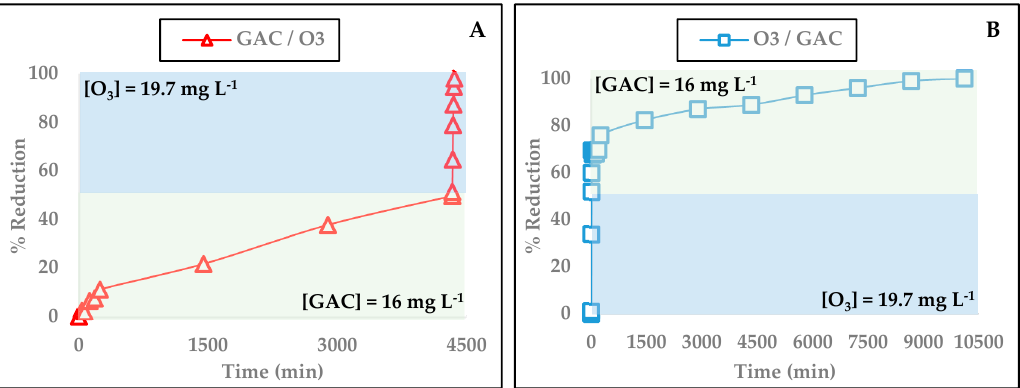
Figure 9. Reduction of simazine during the course of the combined experiment: ( A ) Experimental conditions GAC/O 3 : [Simazine 0 ] = 0.7 mg L − 1 ; [GAC] = 16 mg L − 1 ; [O 3 ] = 19.7 mg L − 1 ; pH 0 6.7; pH (20 min) 4.2–4.5; T = 25 °C. ( B ) Experimental conditions O 3 /GAC: [Simazine 0 ] = 0.7 mg L − 1 ; [O 3 ] = 19.7 mg L − 1 ; [GAC] = 16 mg L − 1 ; pH 0 6.7; pH (20 min) 4.8–5.1; T = 25 °C .